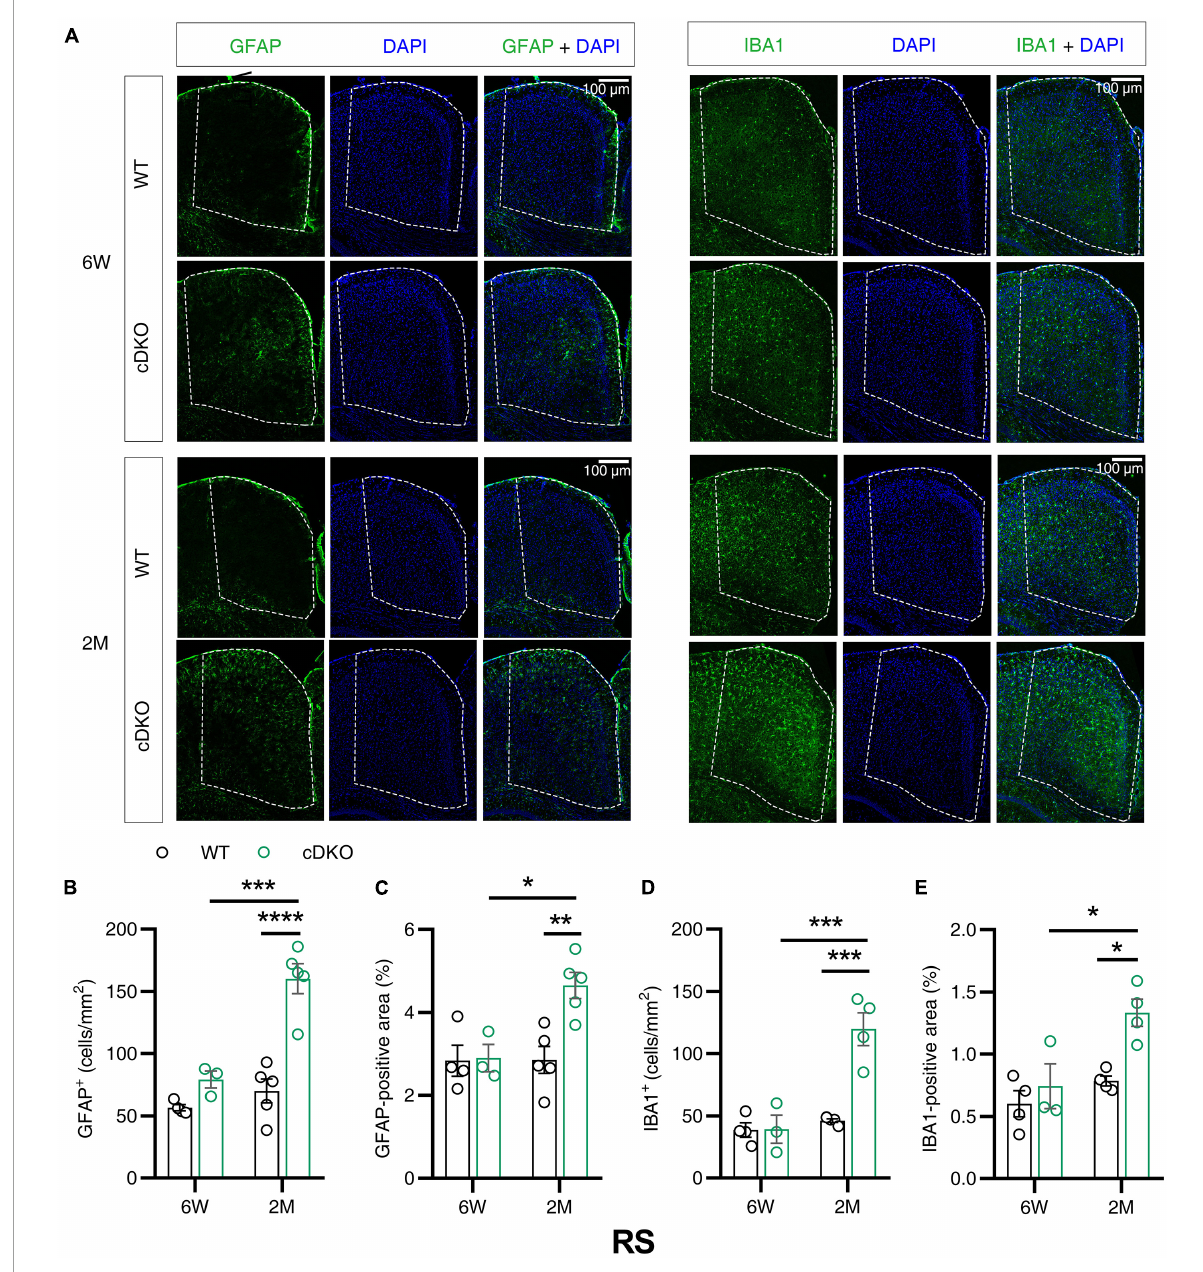
FIGURE3 Astrocyte reactivity and microglial reactivity were increased in the retrosplenial cortex (RS) of PS cDKO mice at 2 months of age. (A) Representative images of immunohistochemistry for GFAP and IBA1 of WT (control) and cDKO brains at 6 weeks (6 W) and 2 months (2 M) of age. (B–E) Quantification of GFAP-positive cells (B) , GFAP-positive areas (C) , IBA1-positive cells (D) and IBA1-positive areas (E) in the RS of WT and cDKO mice. Data are presented as the mean ± SEM ( n = 3–5 for each group). One-way ANOVA analysis followed by Turkey’s test, * p < 0.05, ** p < 0.01, *** p < 0.001, **** p < 0.0001. Scale bar 100 µ